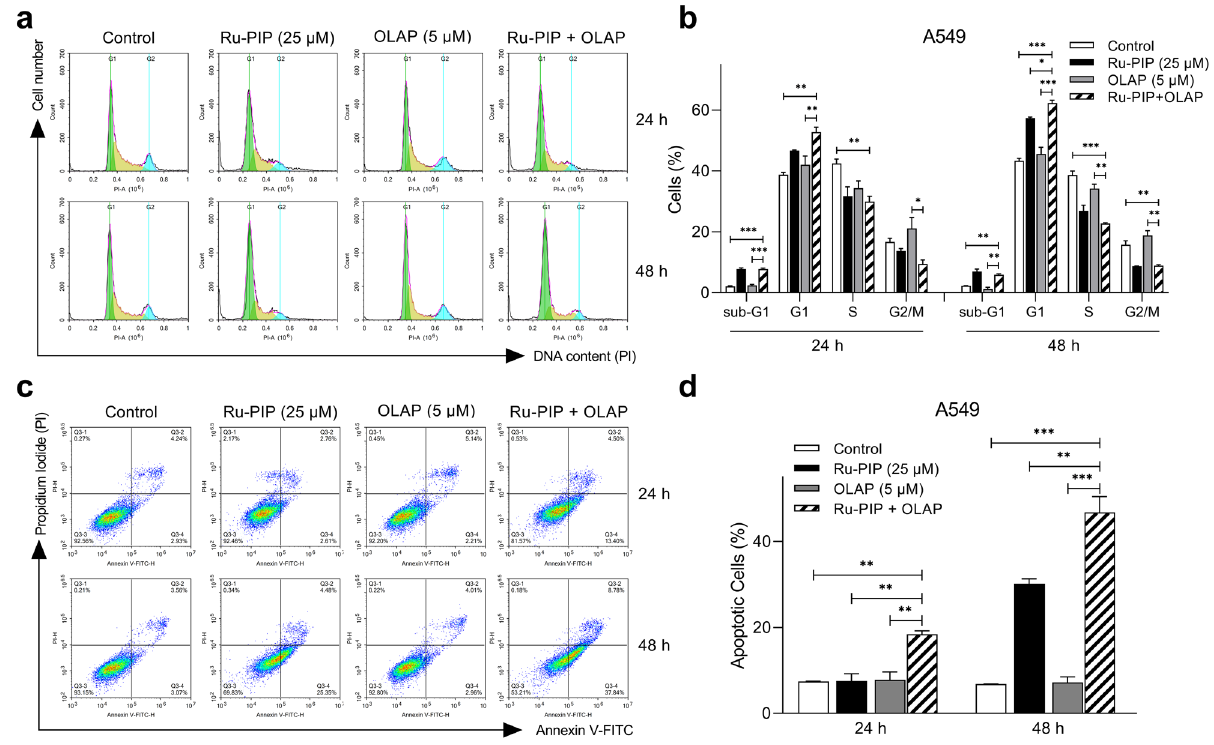
Figure 3. Ru-PIP and Olaparib combination enhances apoptotic cell death. ( a ) DNA histograms showing cell cycle distributions of A549 cells treated with Ru-PIP (25 µM), Olaparib (5 µM) or both for 24 and 48 h. ( b ) Quantification of cell cycle phase distributions from a. ( c ) Annexin V-FITC assay of A549 cells treated with Ru-PIP (25 µM), Olaparib (5 µM) or both for 24 and 48 h. The scatterplots showing the percentage of cells in each quadrant. ( d ) Quantification of apoptotic cells from c. Mean ± SD of two independent experiments. * P < 0.05, ** P < 0.01, *** P < 0.001 by